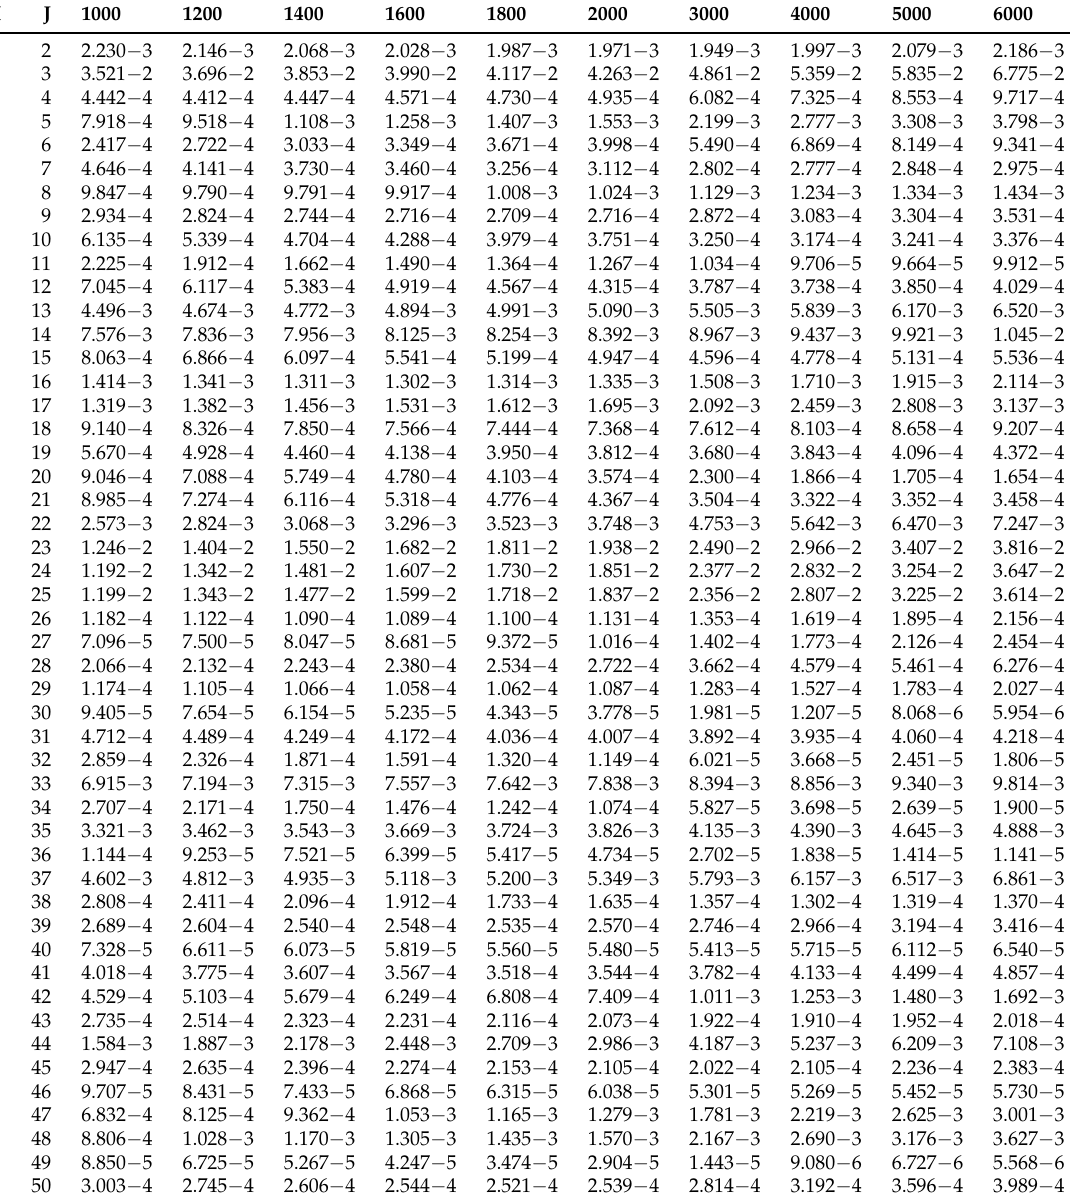
Table 2. Collision strengths ( Ω ) for transitions from the lowest three to higher excited levels of W LXVI in the energy range 1000 to 6000 Ryd. a ± b ≡ a × 10 ± b